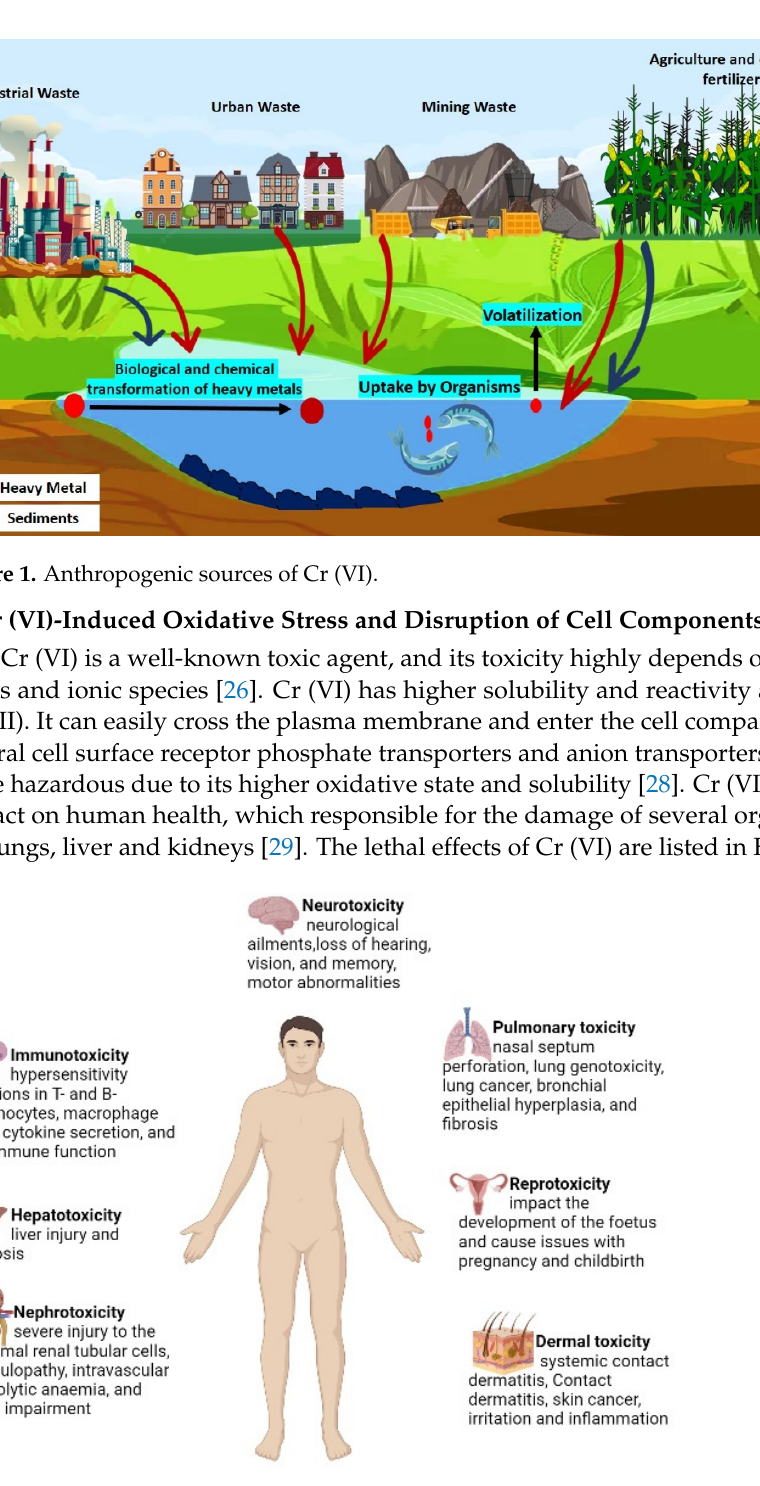
lipid peroxidation and increases lipid metabolites in the urine when Cr (VI) is adminis- trated orally. Other important toxic effects of Cr (VI) are respiratory cancer, chromosomal abnormalities and DNA strand breaks